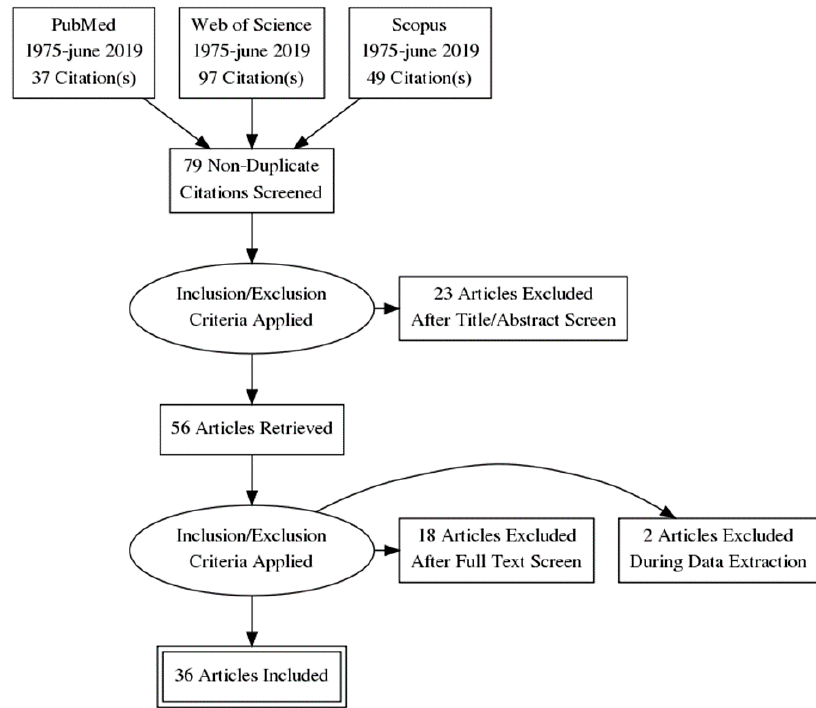
Figure 1. Flow Figure 1. Flow diagram.